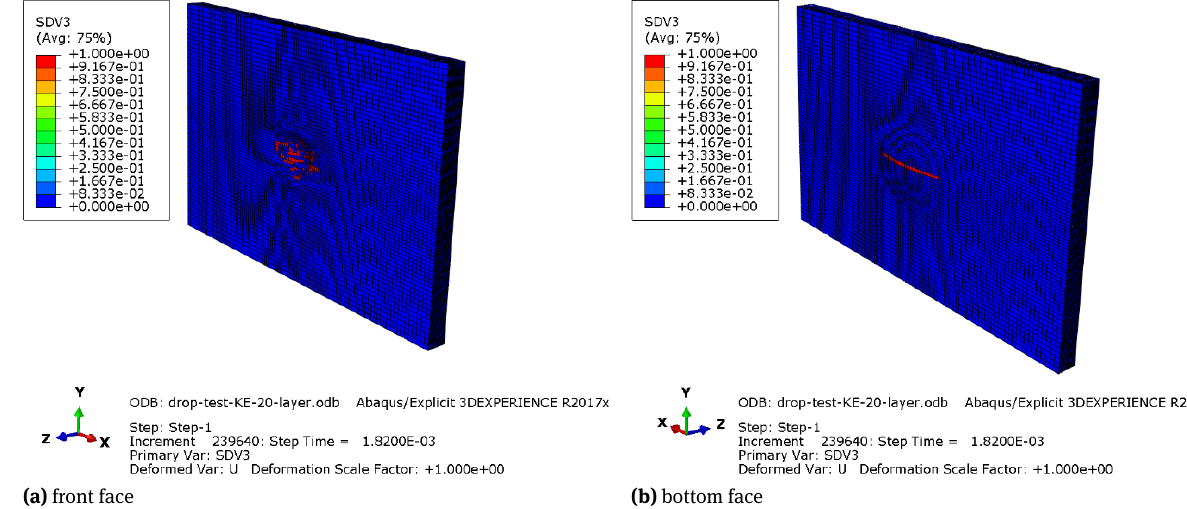
Figure 8: Matrix tensile intralaminar damage of Kevlar